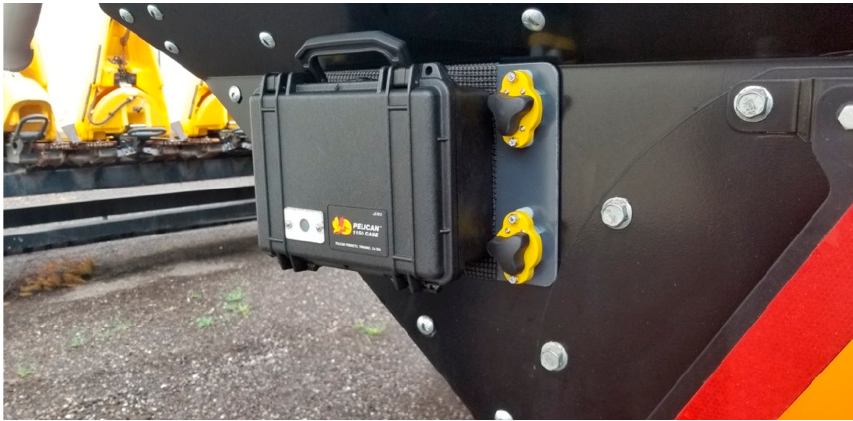
Figure 1. Data collection device mounted on the back of a piece of farm